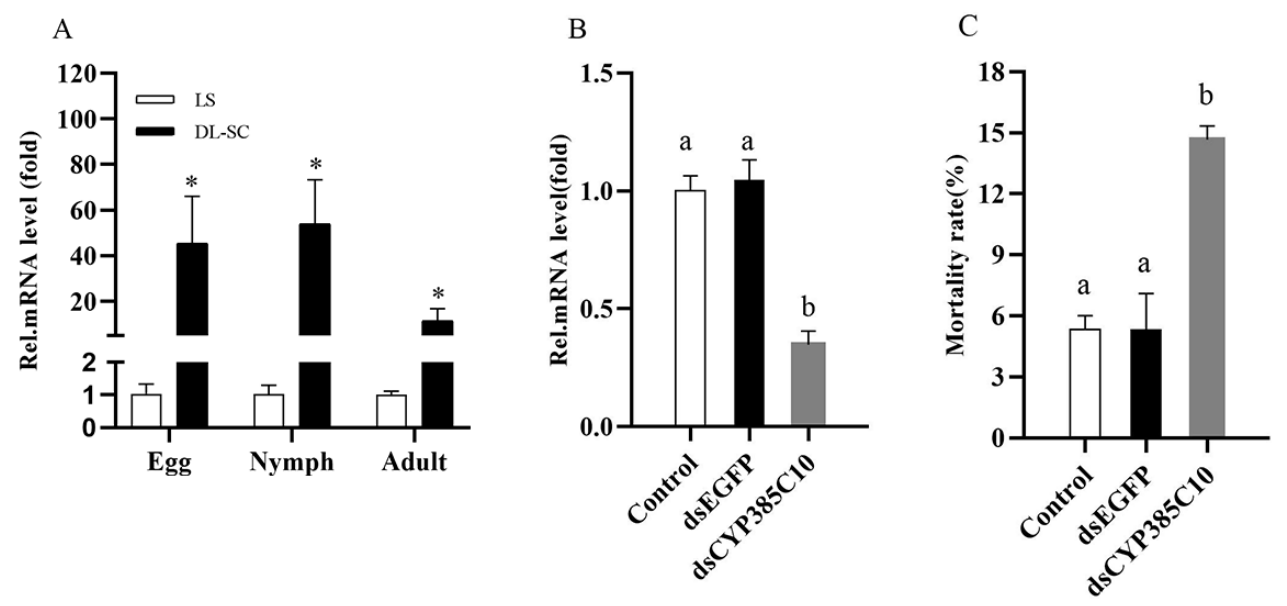
Figure 4. CYP385C10 is involved in spirodiclofen resistance. Relative expression of CYP385C10 at different life stages ( A ). RT-qPCR analysis of CYP385C10 expression after feeding dsRNA in the spirodiclofen-resistant strain of P. citri , relative to expression in control ( B ). Mortality after feeding with CYP385C10 dsRNA in the spirodiclofen-resistant strain ( C ). Error bars represent the standard error of the calculated mean based on three biological replicates. In each panel, means with asterisks indicate significantly different (t-test, p > 0.05), and means with different letters are significantly different (Duncan test, p < 0.05).